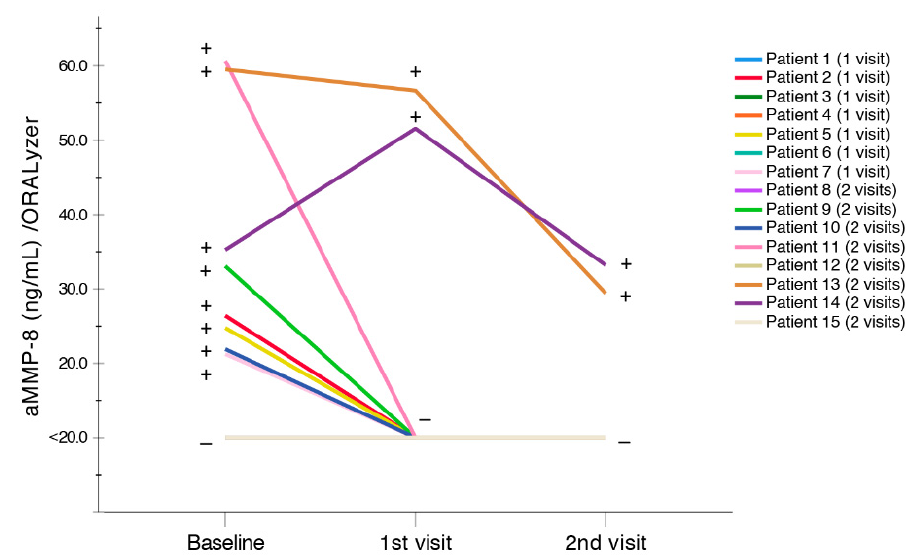
Figure 2. Effects of periodontal treatment; anti-infective treatment/scaling and root planing (SRP) in 15 adult periodontitis patients with elevated aMMP-8 (+, >20 ng/mL) in their mouthrinses monitored by aMMP-8 PoC-system (PerioSafe-ORALyzer kit) for 1st recall visit (4 weeks) and 2nd recall visit (8 weeks). (–) indicates <20 ng/mL aMMP-8 in mouthrinse.